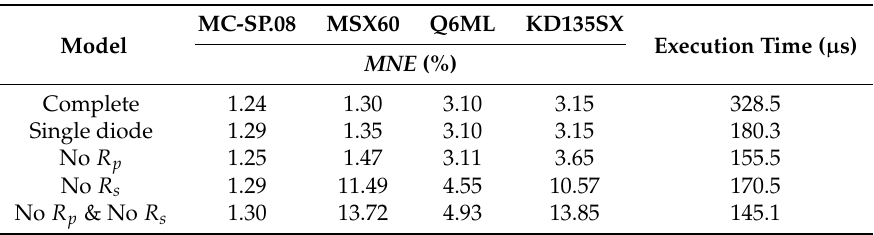
Figure 10. Normalized error obtained while reconstructing the Several I – V curve for Kyocera KD135SX PV module with different model complexity. Table 2. Mean normalized error ( MNE ) and execution times obtained while tuning the model complexity for different PV